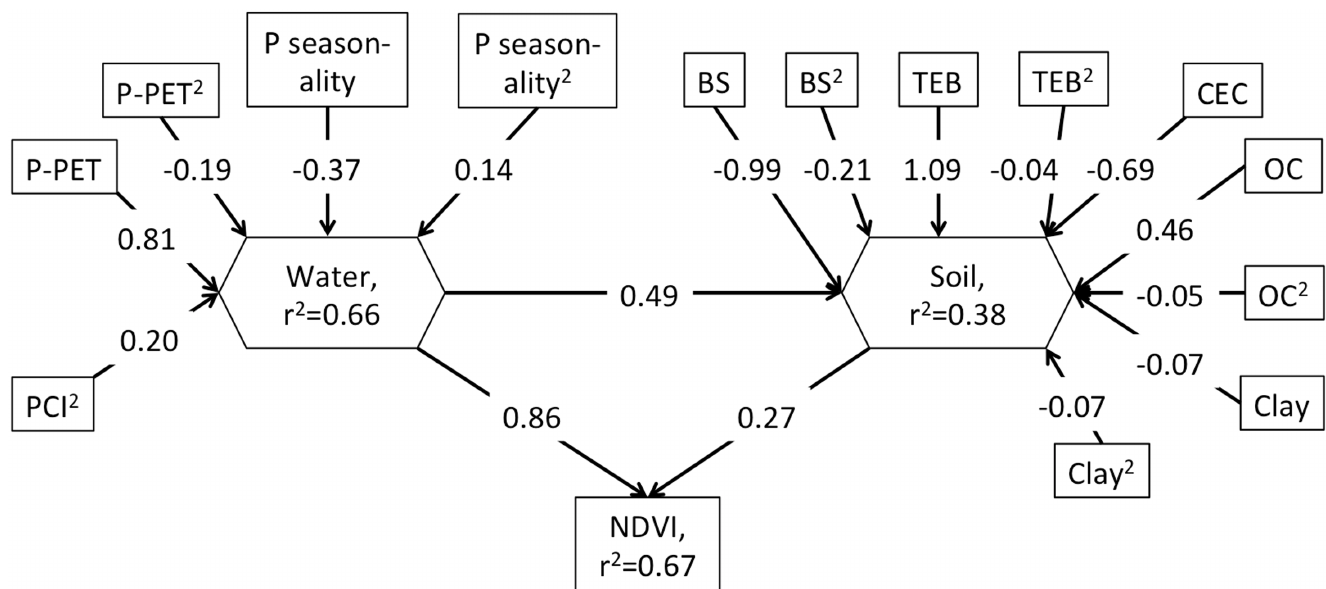
Fig 7. SEM representing the standardised path coefficients and r 2 values for significant (P < 0.001) paths from exogenous environmental variables including water availability measured as the average of monthly precipitation — potential evapotranspiration (P-PET), precipitation seasonality, precipitation concentration index (PCI), base saturation (BS), total exchangeable bases (TEB), cation exchange capacity (CEC), organic carbon (OC) and clay through two composite variables (Water and Soil) to NDVI. The direct influence of water availability on NDVI (0.86) is greater than the indirect influence through the soil composite variable (product of coefficients = 0.13). The Chi 2 P value was 0.97 with d.f = 1.